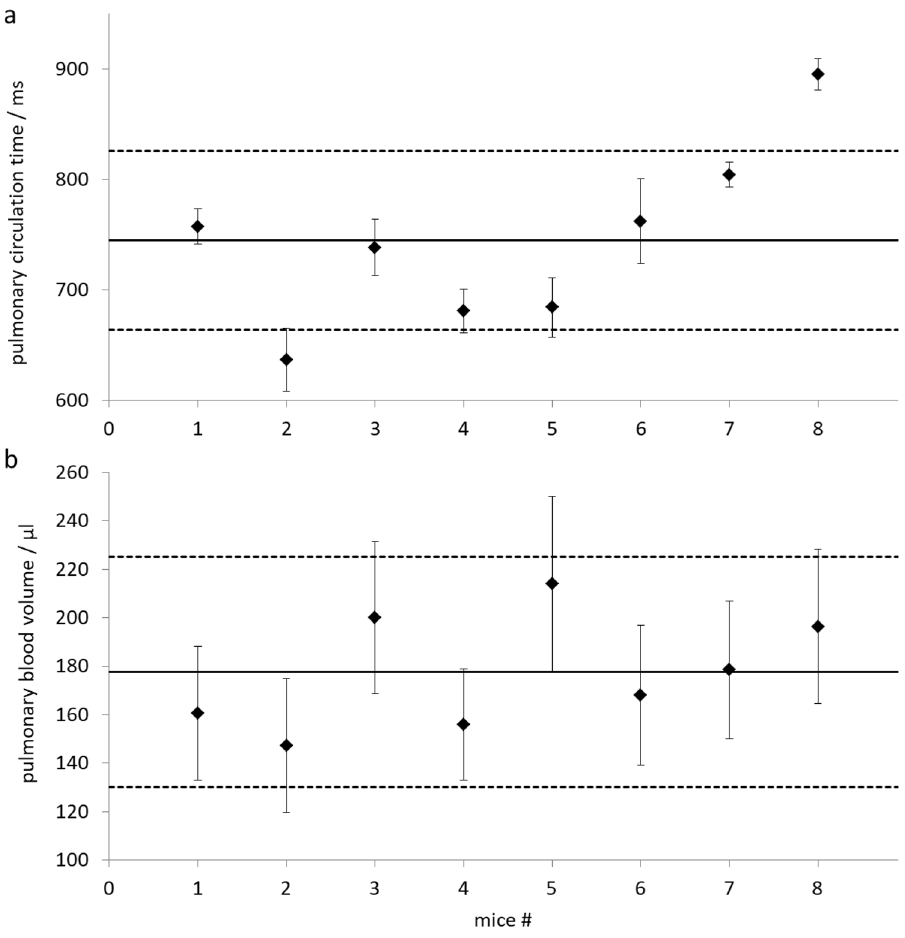
Figure 7. ( a ) Pulmonary transit times and ( b ) pulmonary blood volume in eight mice. Error bars indicate the standard error and the dashed lines the 95% confidence intervals around the mean values of around 745 ms and 177